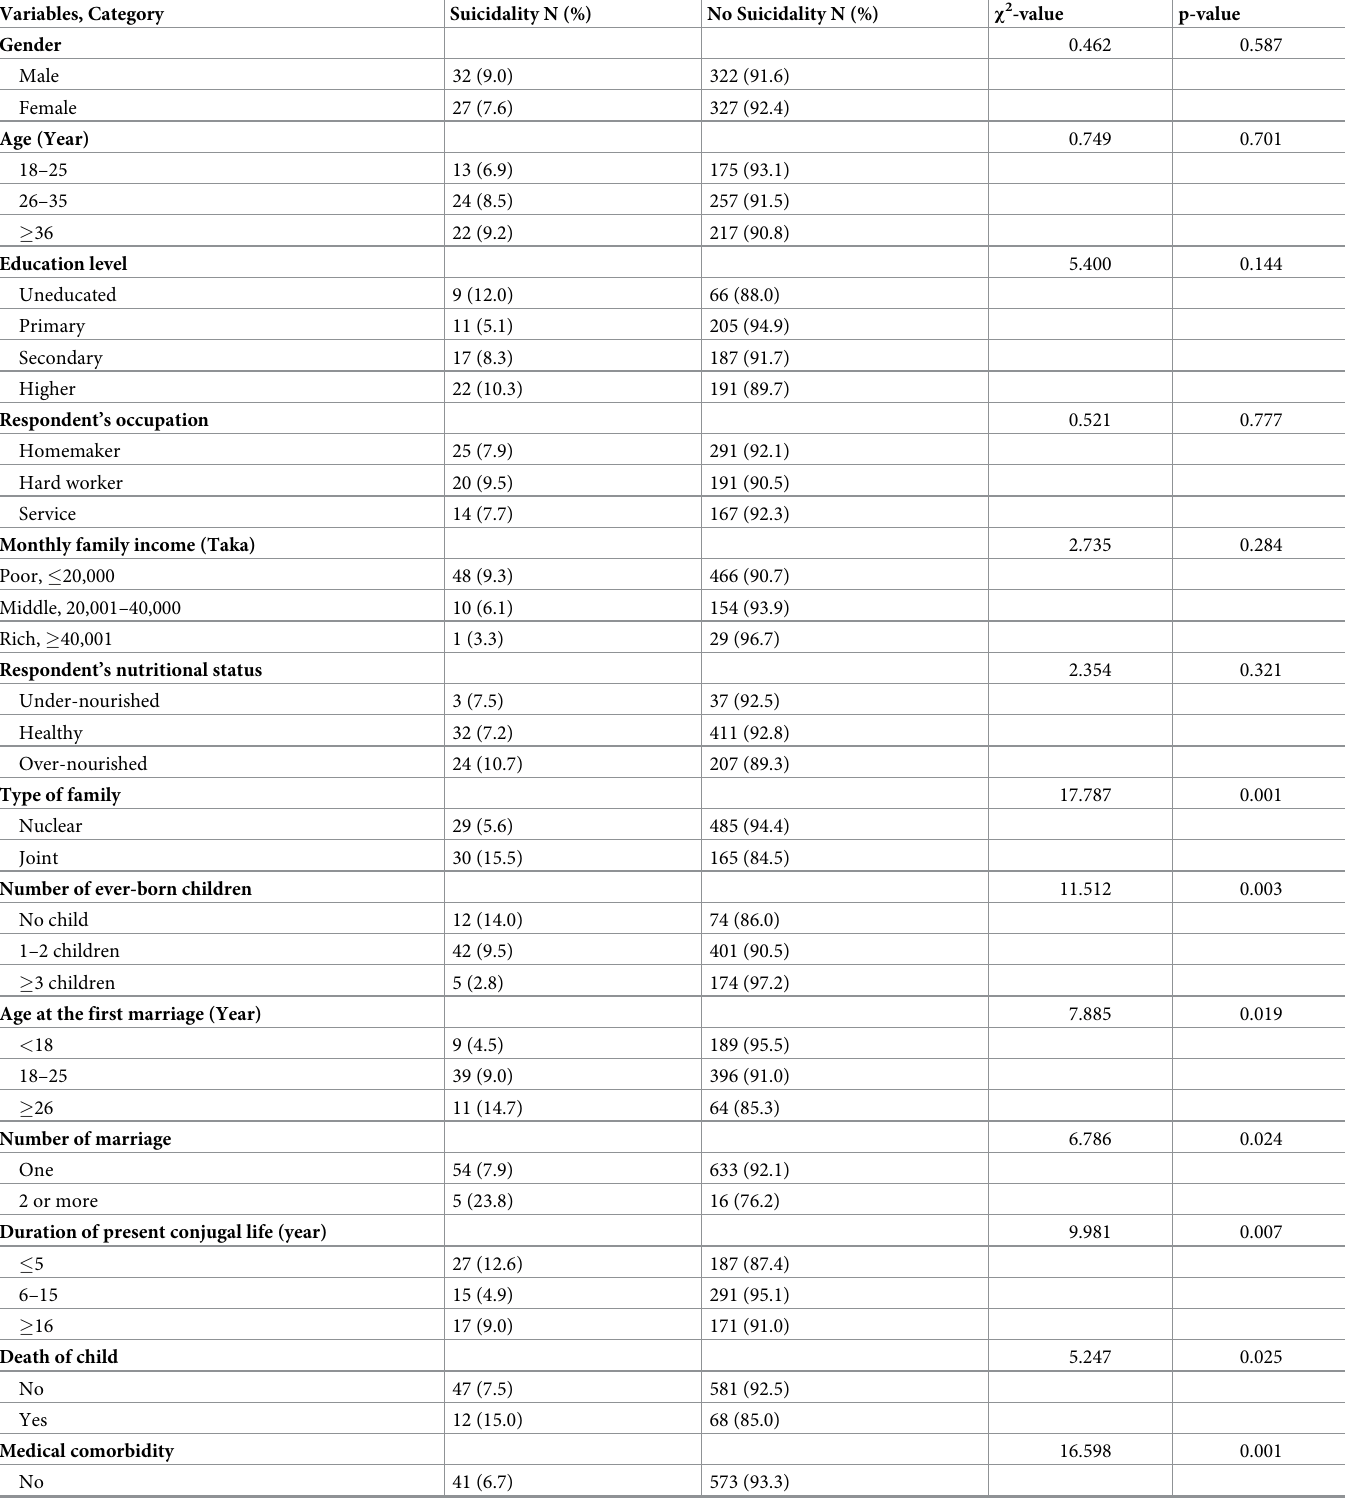
Table 2. Association between selected independent variables and suicidality among married adults (n =